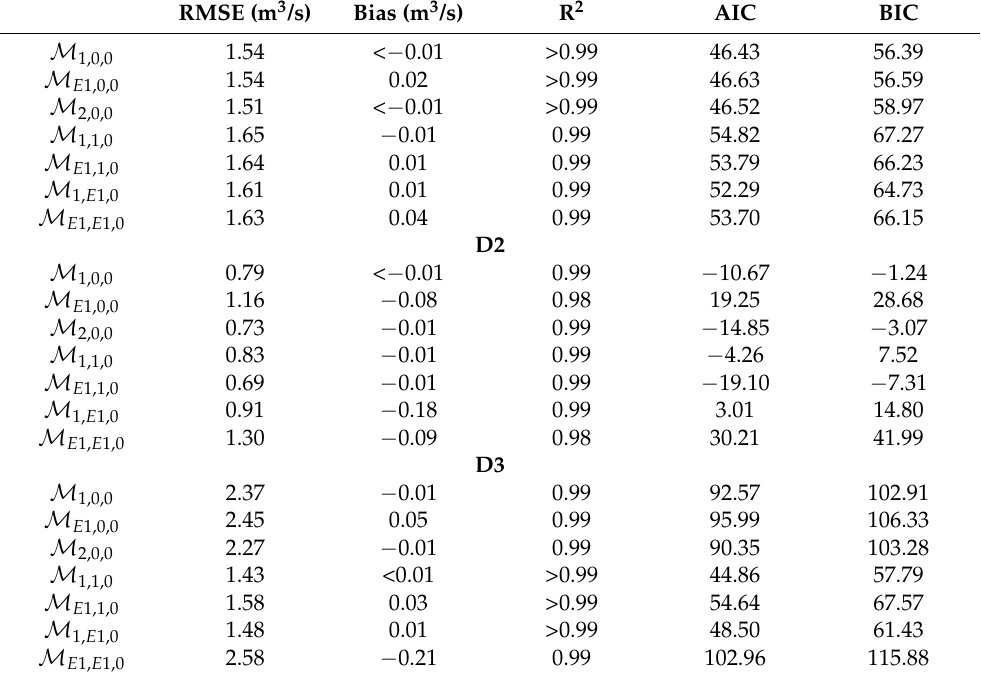
Table 2. The fitting efficiency and accuracy metrics of all candidate nonstationary models for each dataset. The selected optimal models in terms of the fitting efficiency are highlighted in